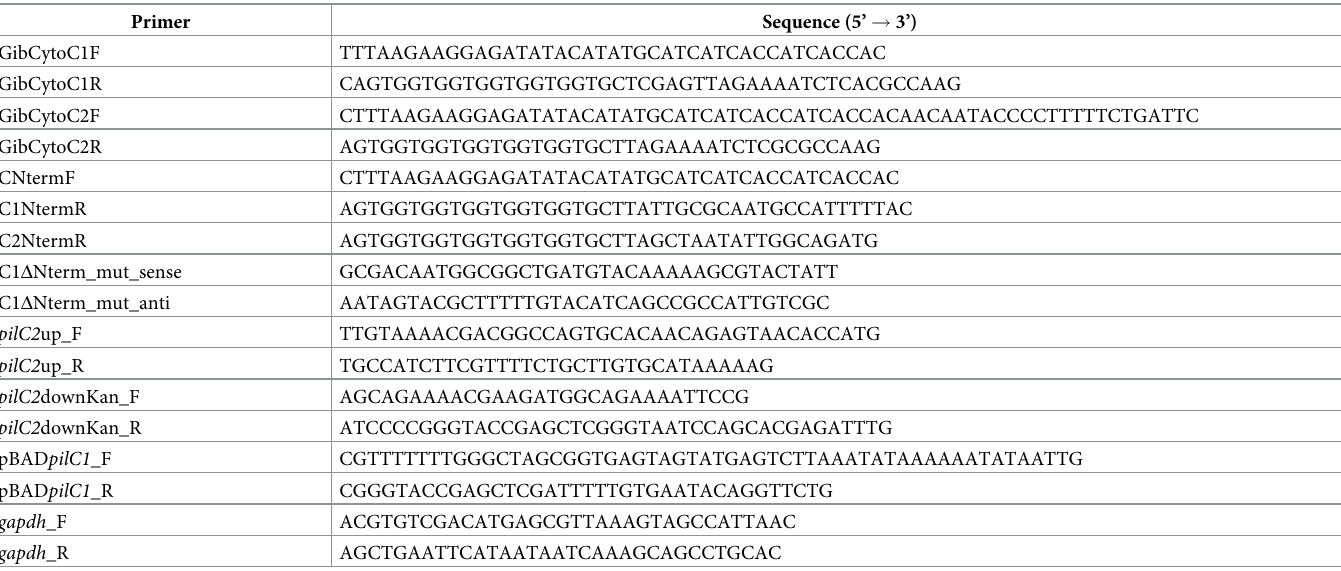
Table 2. Primers used in this